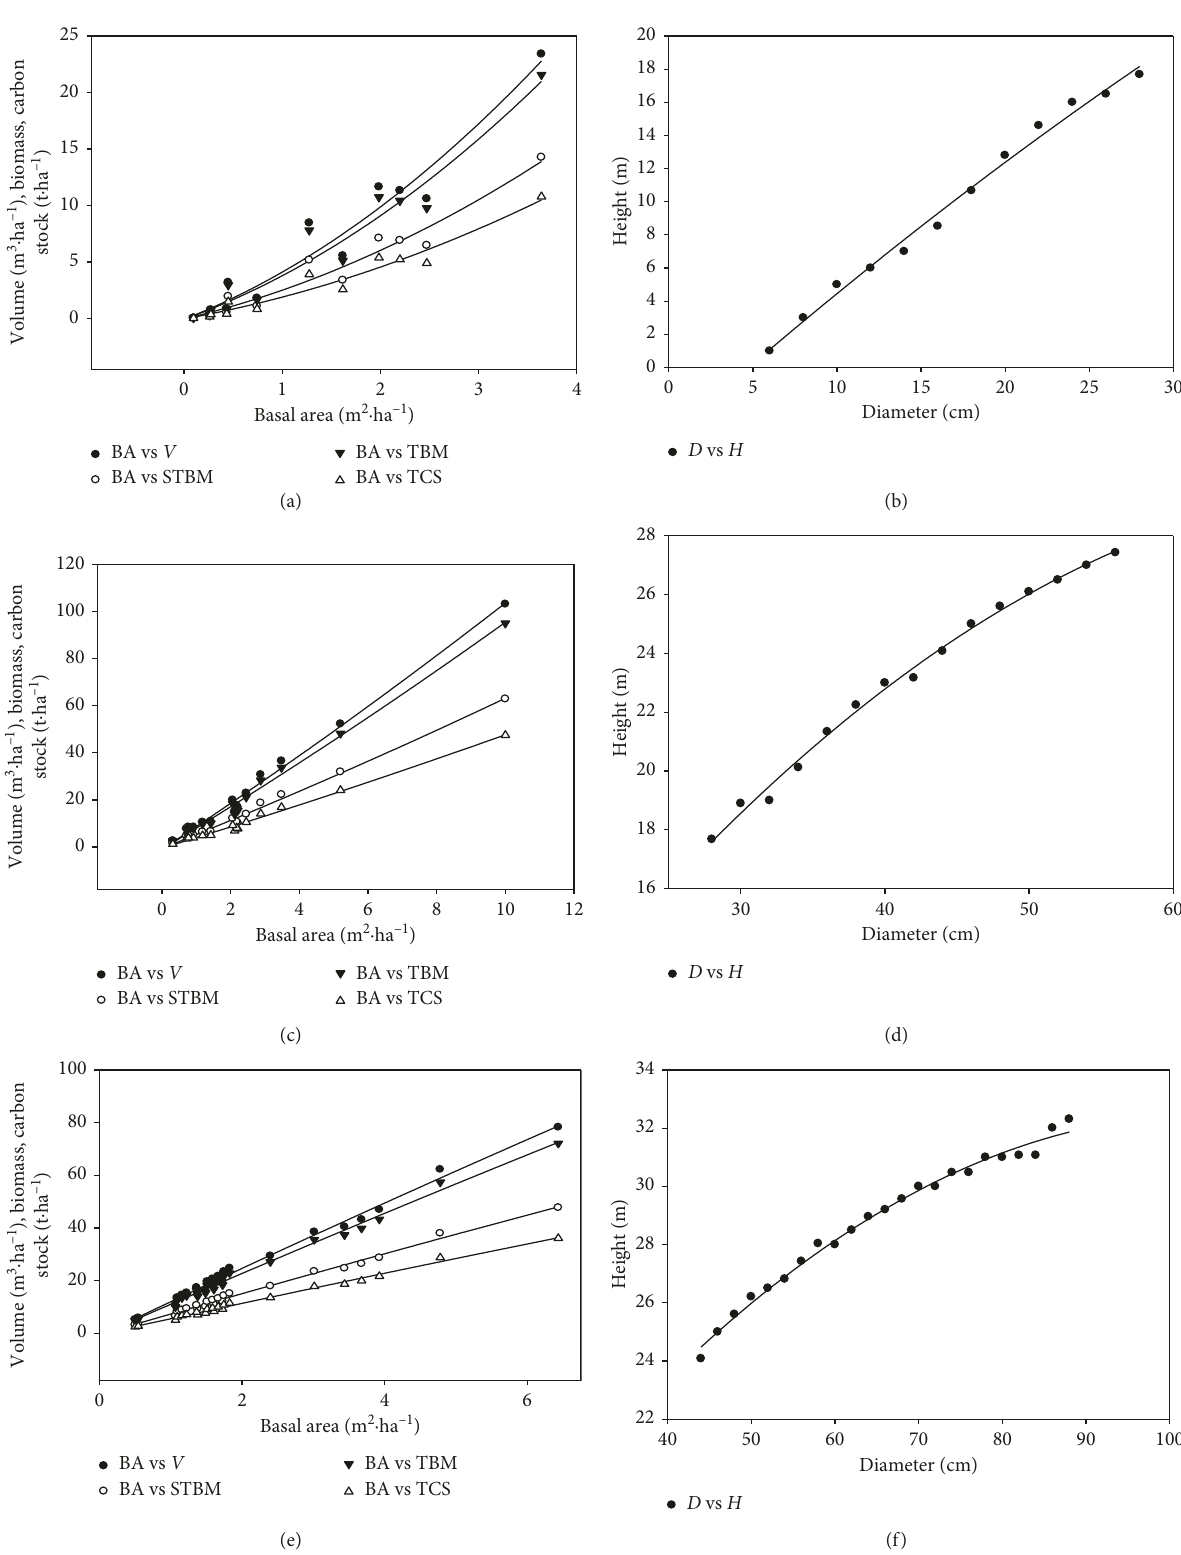
Figure 2: Relationship between D and H , BA, and V , STBM, TBM, TCS in the young (a, b), mature (c, d), and overmature (e, f). D � diameter (cm), H � height (m), BA � basal area (m 2 · ha − 1 ), V � volume (m 3 · ha − 1 ), STBM � stem biomass (t/ha), TBM � total biomass (t/ha), TCS � total carbon stock (t · ha − 1